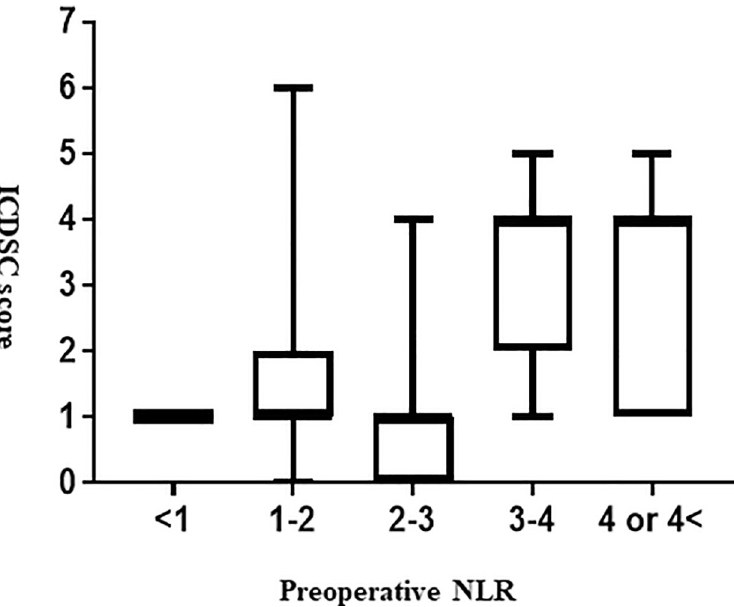
Fig 2. The association between the preoperative NLR and the maximum ICDSC score. Kruskal-Wallis test and Dunn’s post hoc test were used to determine the association between the preoperative NLR and the maximum ICDSC score. NLR: Neutrophil-to-lymphocyte ratio, ICDSC: Intensive Care Delirium Screening Checklist. � p < 0.05 vs. NLR < 1 Dunn’s post hoc tests.